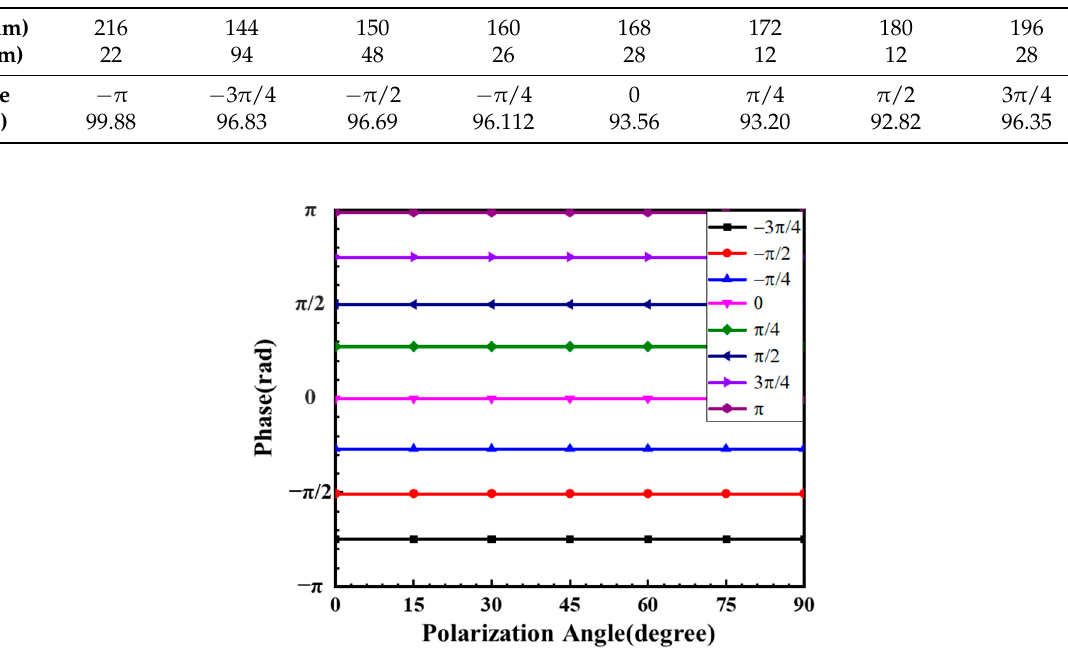
Figure 4. The verification of polarization independence for the nano-ring.